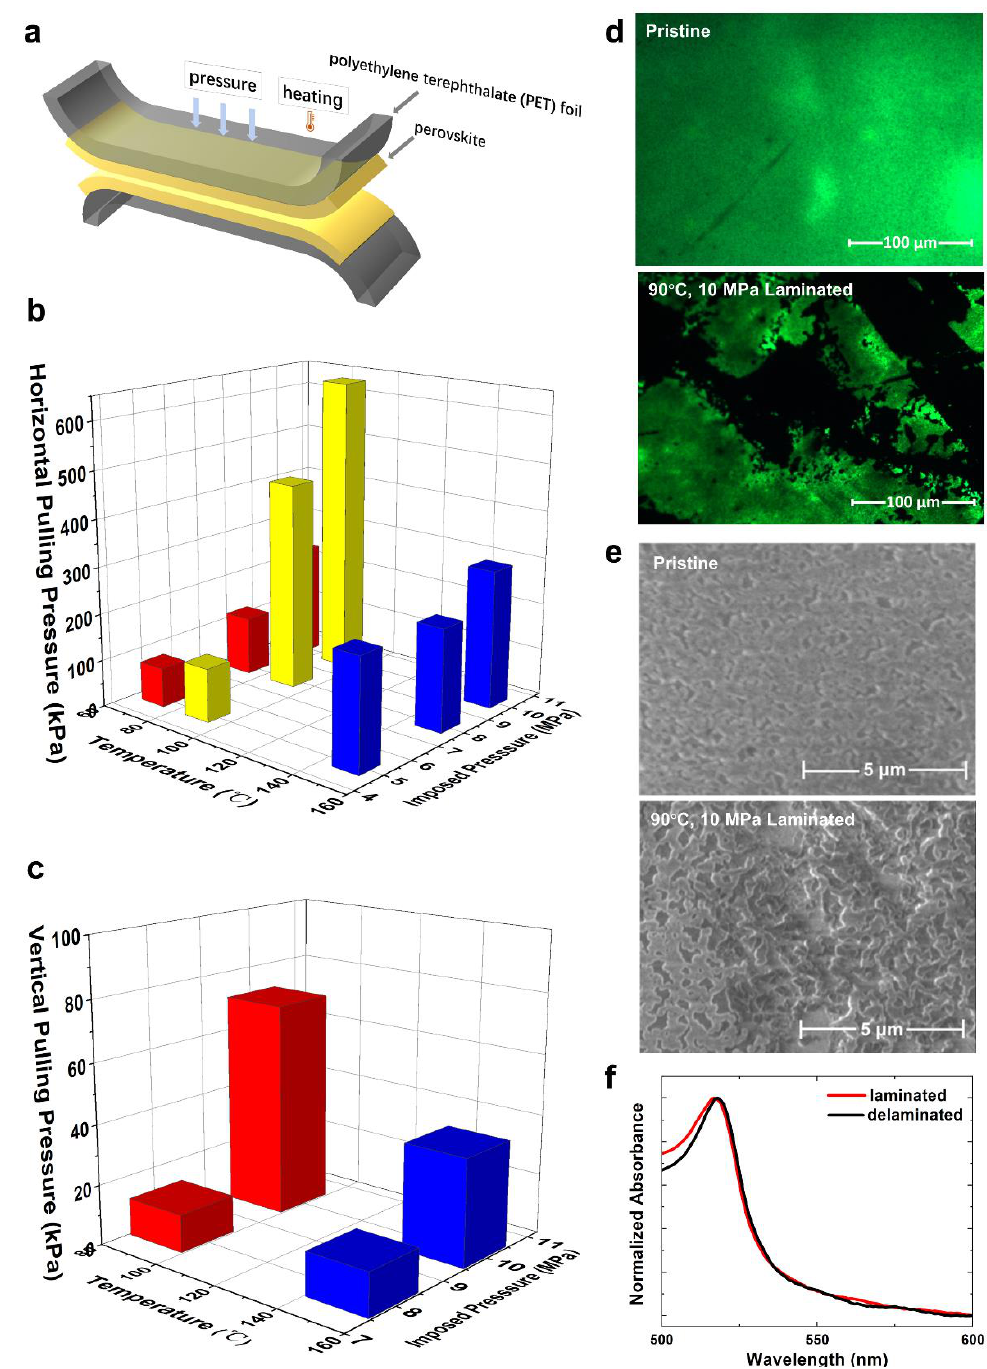
Figure 1. ( a ) Schematic illustration of the lamination process of perovskite thin films on flexible substrates. ( b ) Horizontal and ( c ) vertical pulling pressure of perovskite laminates as a function of temperature and imposed pressure. ( d ) Metallurgical microscope and ( e ) SEM images of the pristine CsPbBr 3 thin film and the laminated CsPbBr 3 thin film at 90 °C and 10 MPa. ( f ) Normalized absorbance spectra of the laminate prepared at 90 °C and 10 MPa and the corresponding delaminated CsPbBr 3 film.